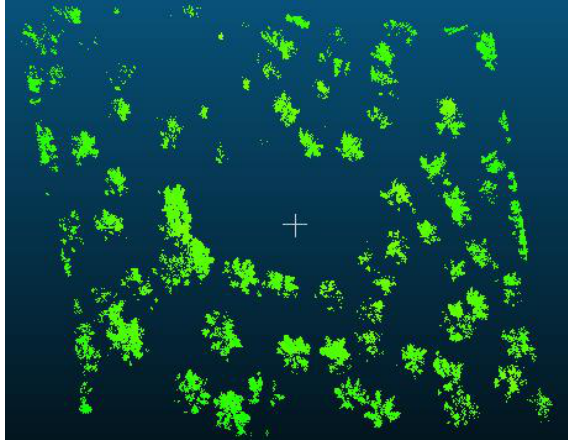
Figure 14.The test data of Chengde